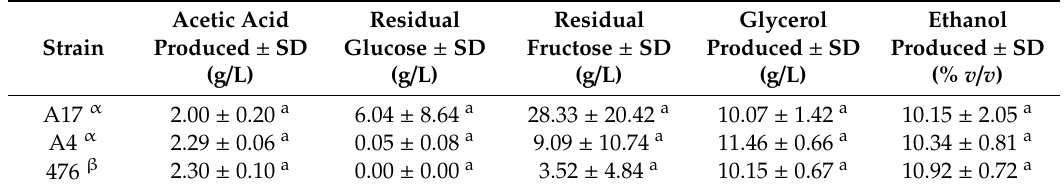
Table 3. Oenological parameters improved strain “476” and their F 1 parental strains. Ethanol Glycerol Residual Residual Acetic Acid Produced ± SD Produced ± SD Fructose ± SD Glucose ± SD Strain Produced ± SD (% v / v ) (g / L) (g / L) (g / L) (g / L) A17 α 2.00 ± 0.20 a 6.04 ± 8.64 a 28.33 ± 20.42 a 10.07 ± 1.42 a 10.15 ± 2.05 a A4 α 2.29 ± 0.06 a 0.05 ± 0.08 a 9.09 ± 10.74 a